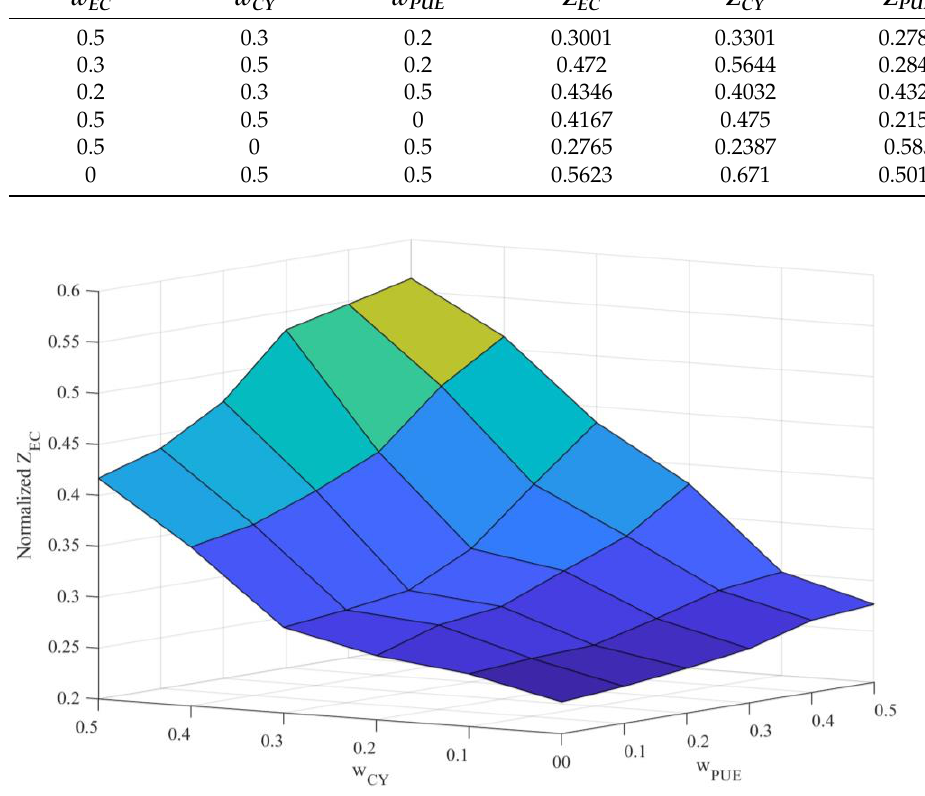
Figure 9. Sensitivity analysis of the environmental weights on the normalized economic cost: the lower the value for the weights of environmental objectives (either w CY or w PUE ) is, the higher the value for the economic objective ( w EC ) is considered, and thus, a lower economic cost ( Z EC ) is obtained.